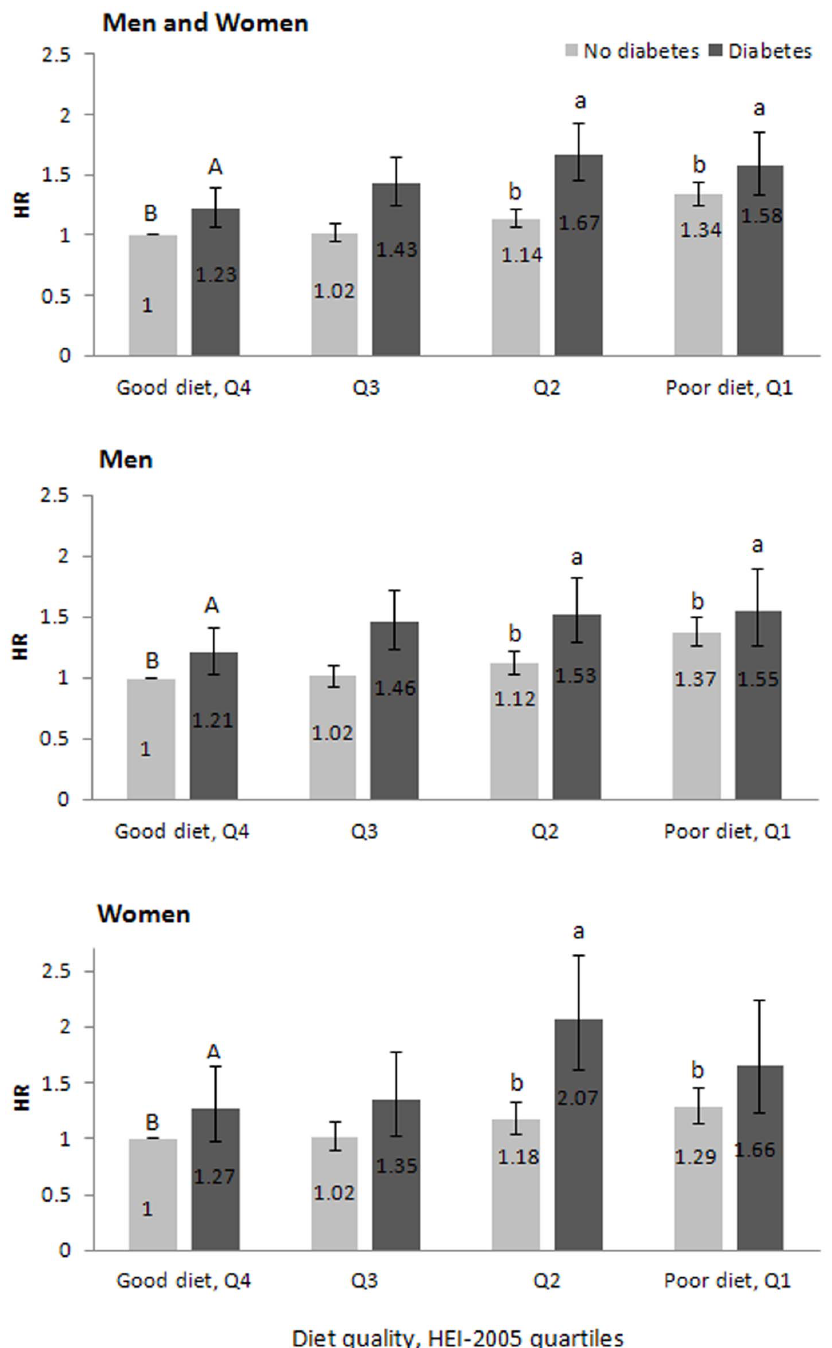
Figure 1. Combined Effect of Diet Quality and Diabetes on Risk of Colorectal Cancer among Men and Women Combined (Upper Panel), Men (Middle Panel), and Women (Lower Panel). Error bars indicate 95% confidence interval. In each panel, columns with letter ‘a’ exhibit a significantly greater HR compared to the column with letter ‘A’ (Diabetes and Good diet) and columns with letter ‘b’ exhibit a significantly greater HR compared to the column with letter ‘B’ (No diabetes and Good diet) (P ,